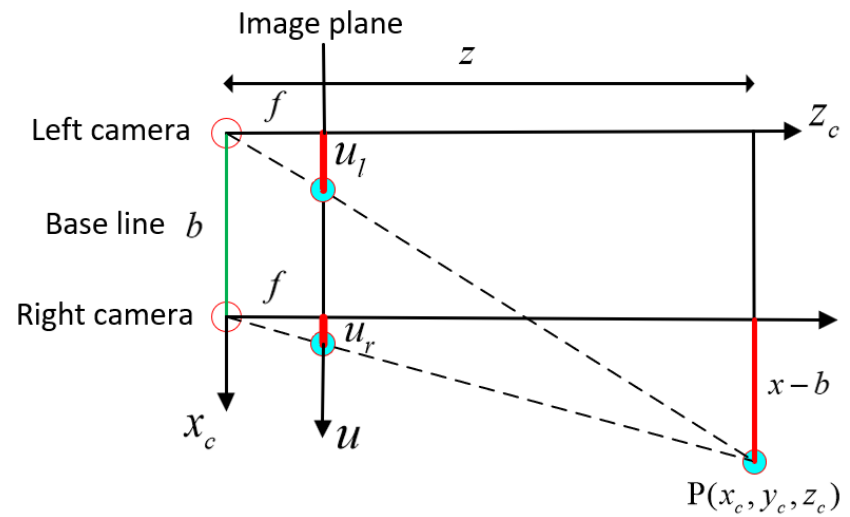
Figure 2. Imaging principle of binocular stereo